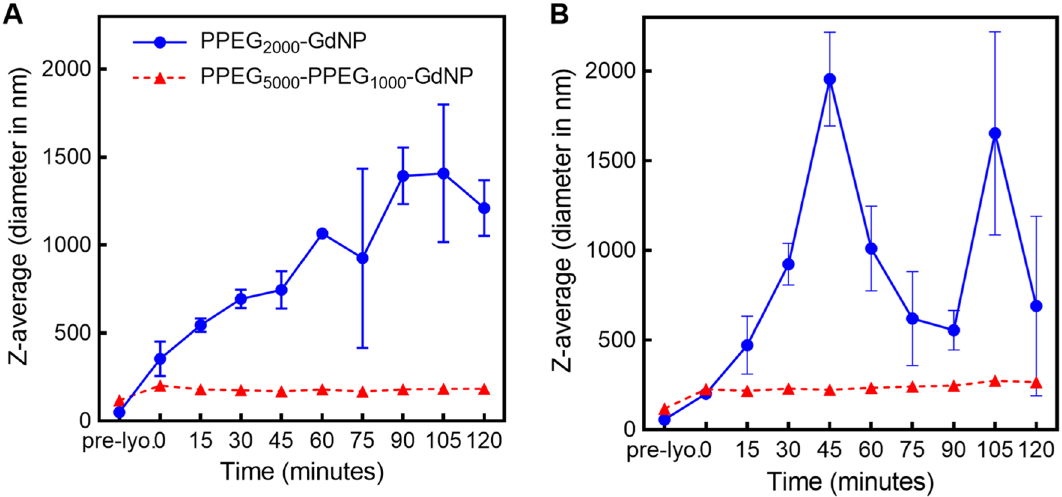
Figure 3. Time-course diameters of resuspended PPEG 2000 -GdNP and PPEG 5000 -PPEG 1000 -GdNP at 37 °C. The contrast agents were redispersed in ( A ) saline and ( B ) a mouse serum mimic for (HU) and gadolinium concentration in mg/mL ([Gd]) was calculated to be HU = 31[Gd] – 3 (Supplementary Fig. S1). Hence, a contrast value of 3100 HU is anticipated with 100 mg/mL of gadolinium. The CT contrast values obtained from PPEG 2000 -GdNP and PPEG 5000 -PPEG 1000 -GdNP were 3244 ± 57 HU and 3195 ± 62 HU, respectively, corresponding to 105 ± 2 mg/mL and 103 ± 2 mg/mL of gadolinium respectively. In vitro and in vivo characterization. In cell culture experiments with PPEG 2000 -GdNP and PPEG 5000 -PPEG 1000 -GdNP, greater than 75% viability of C2C12 mouse myoblast cells was found for all gado- linium concentrations evaluated, up to 1.0 mg/mL (Supplementary Fig. S3); the GdNP are not considered toxic according to the American Society for Testing and Materials 44 . In addition, micro-CT images of the dorsal inter- scapular region following subcutaneous injection (Supplementary Fig. S4) showed contrast enhancement near the injection site was nearly gone after two weeks. Full body gross examinations showed normal tissues.